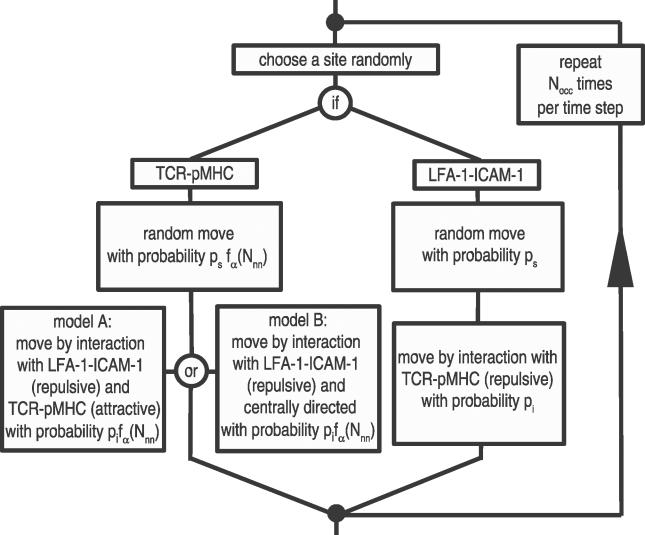
Flowchart of the Cellular AutomatonSee the text for details.